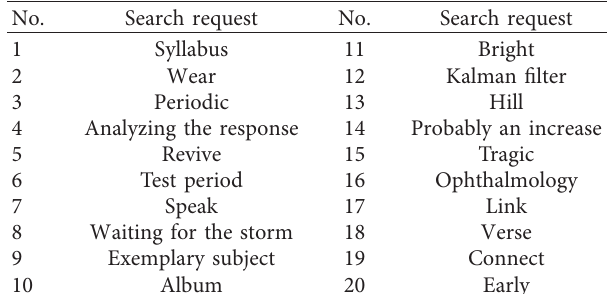
Table 4: Examples of 20 search requests of the prototype of DIRS search engine.